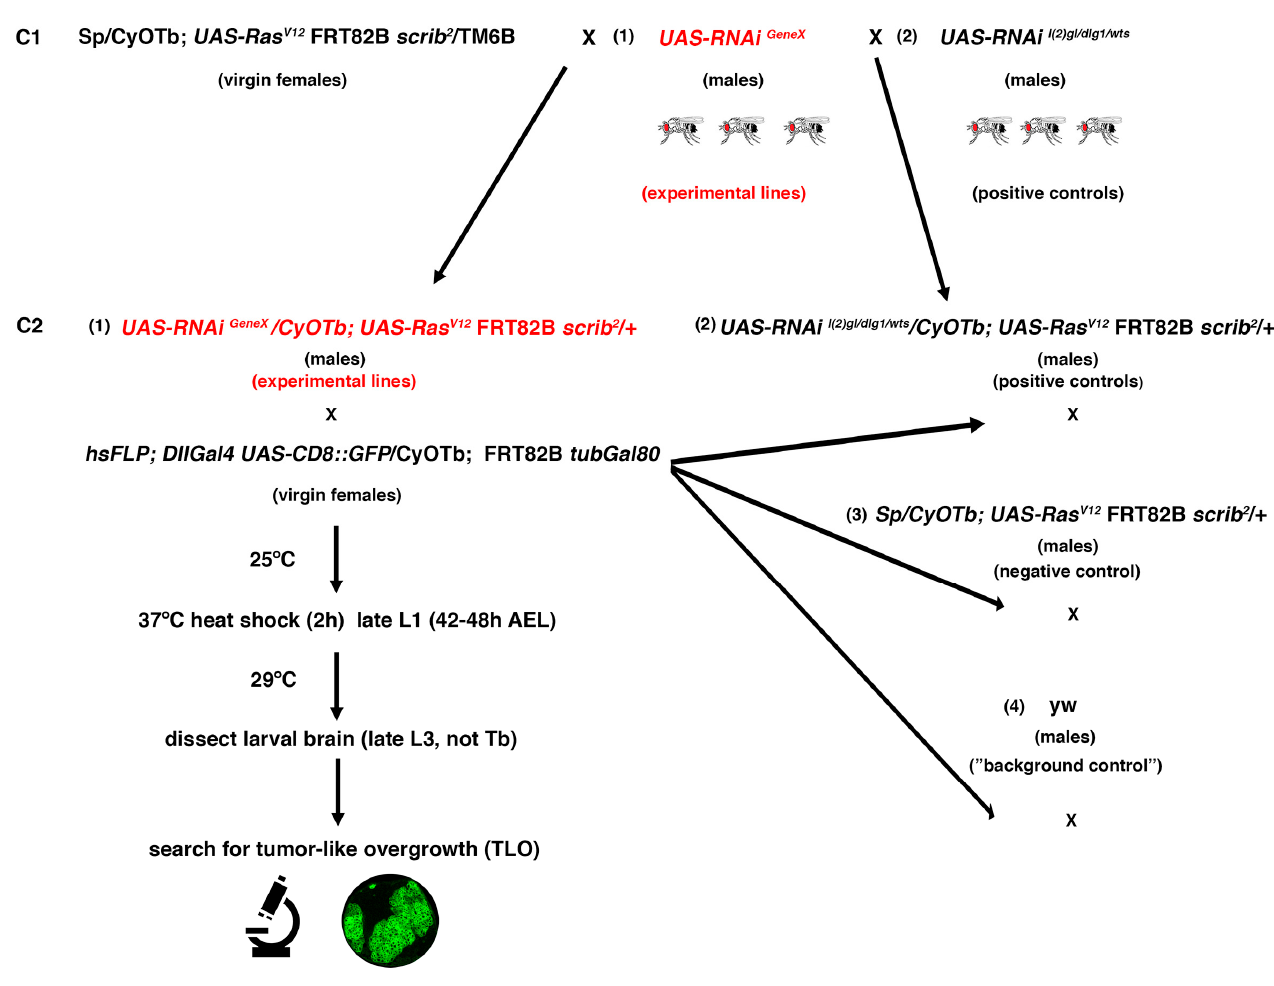
Figure 3. Outline of the crossing scheme and workflow for the RNAi screen. C1: Crosses 1; C2: Crosses 2; L1: first instar larvae; L3: third instar larvae; AEL: after egg laying; TLO: tumor-like overgrowth.